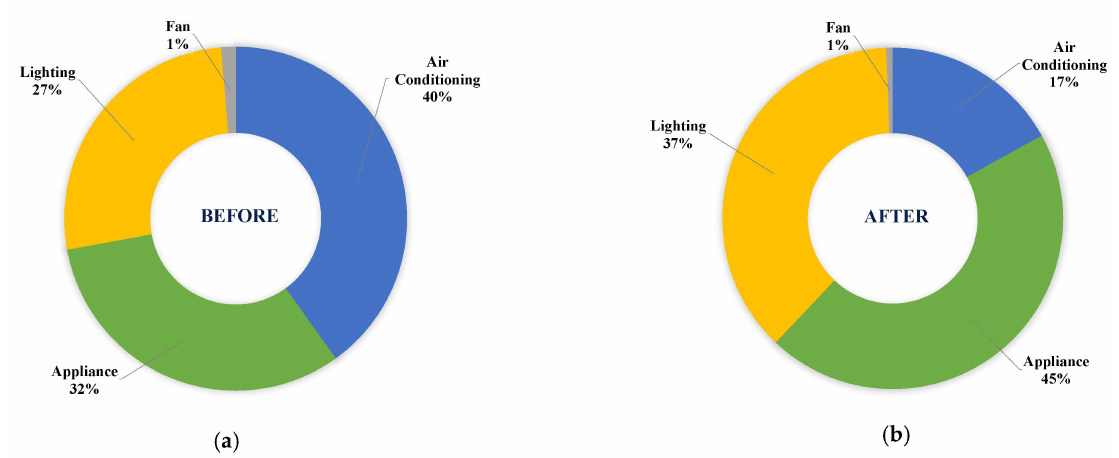
Figure 10. Comparison of annual electricity use breakdown for a residential building case study before ( a ) and after ( b ) renovation.